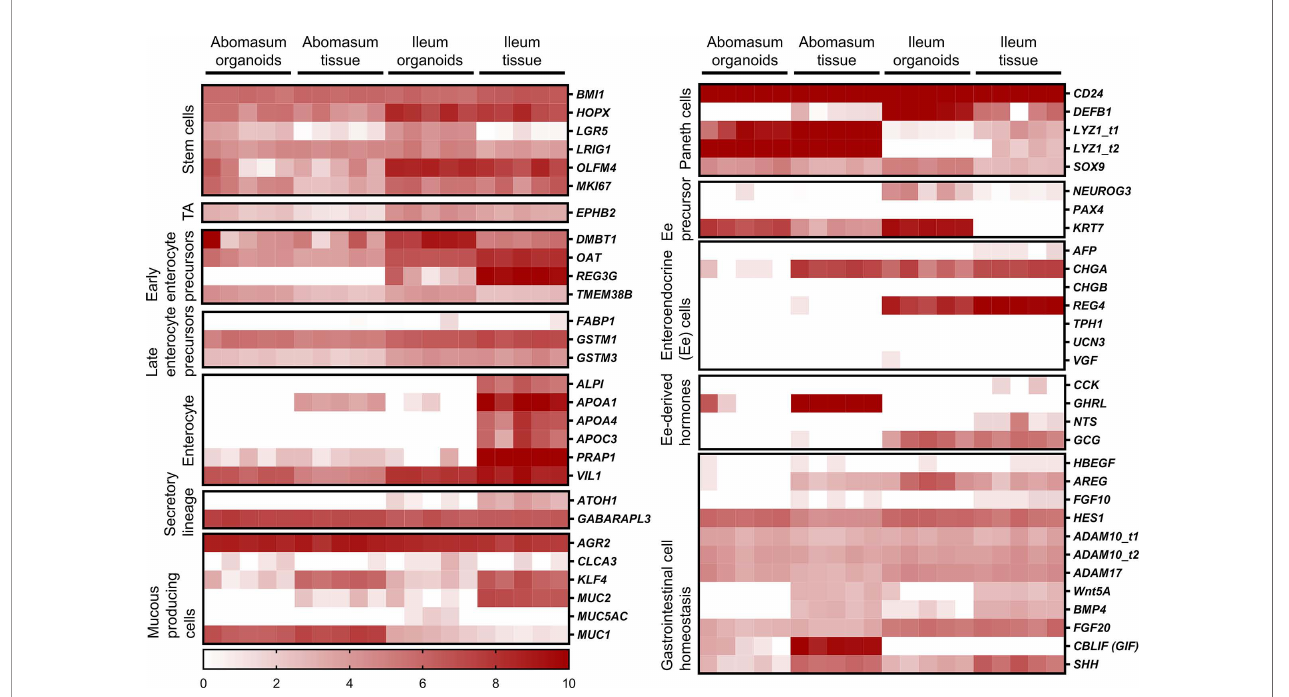
FIGURE 7 | Heat map showing the expression of genes associated with gastrointestinal epithelia in abomasum and ileum tissue and organoids. RNA-seq analysis was performed to compare gene expression in abomasal and ileal tissue derived from fi ve lambs and abomasum and ileum organoids across multiple passages. Squares from left to right under “ abomasum tissue ” and “ ileum tissue ” represent lambs T1-T5. Squares from left to right under abomasum organoids and ileum organoids represent passages P0-P4. Scale = log 2 transcripts per million reads. Ee: enteroendocrine. Details of genes included in the heat map, including ENSOART sequence identi fi ers, are shown in Supplemental File 2